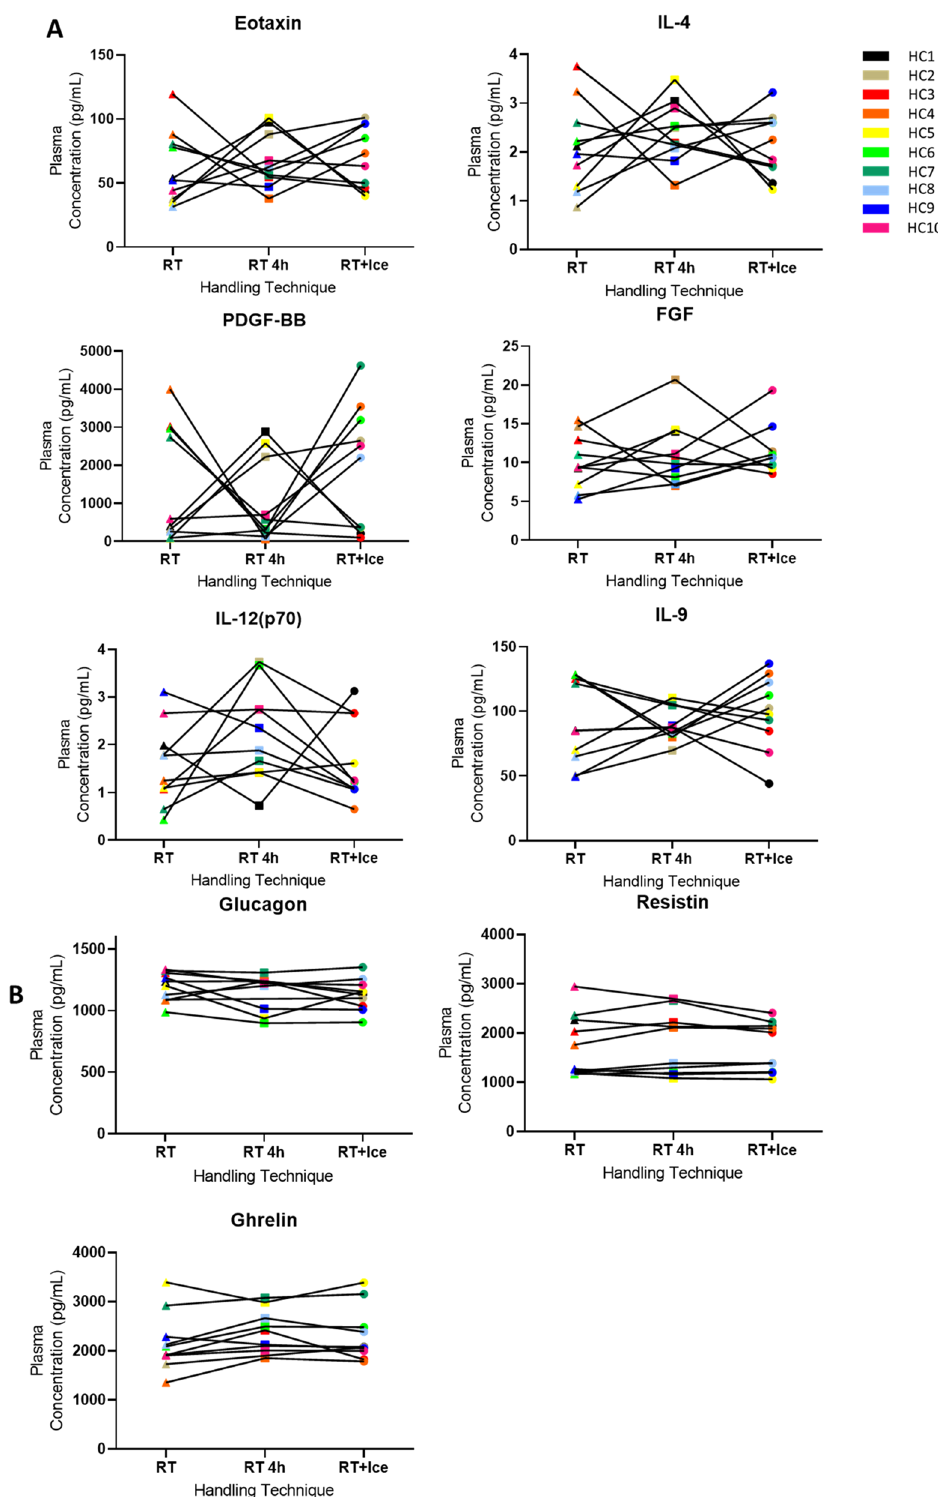
Figure 4. The effects of delay pre-processing protocols on plasma analyte levels. The plasma levels of selected analytes in healthy control samples following three pre-processing protocols are shown. The reference protocol 1 h at room temperature (RT) and two delay protocols, 1 h at RT followed by a further 3 h on ice (RT + Ice) or 1 h at RT followed by a further 3 h at RT (RT 4 h) were compared. ( A ) While no statistically significant differences are observed for some analytes, specific individual samples undergo considerable changes in response to handling variables. ( B ) Some analytes demonstrated minimal changes. Paired t-tests were performed to determine if a significant difference between analyte levels in samples from delay and reference protocols